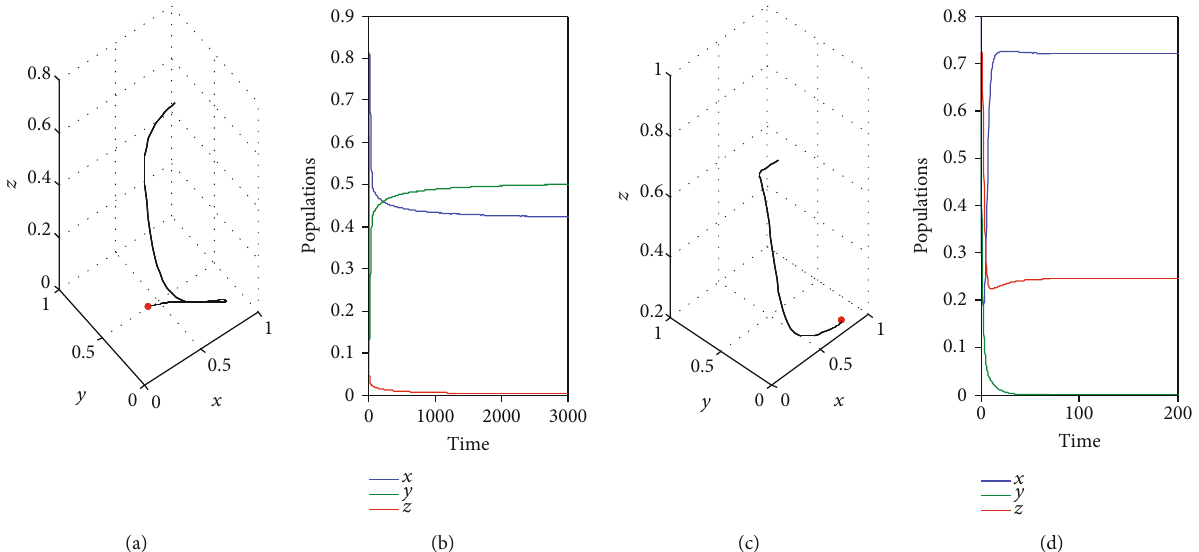
= 0 : 1 approaches asymptotically to GPFP. (b) Time series 12